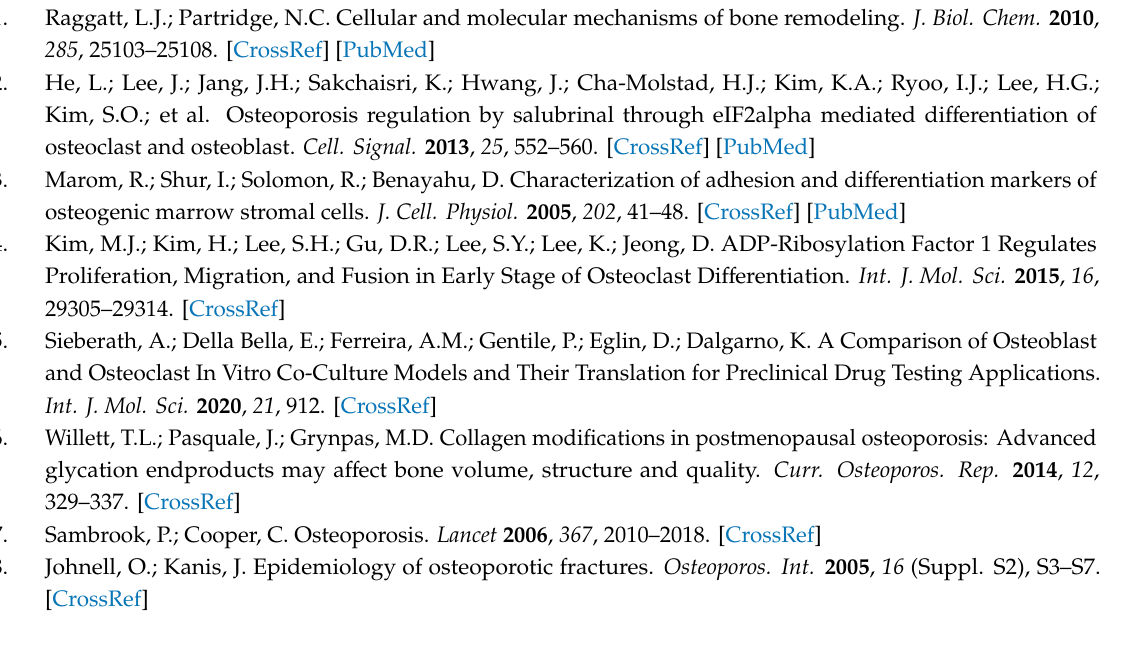
Figure S1: Fractionation and isolation of the bioactive component isolated from LRC, Figure S2: 1 H-NMR (a), 13 C-NMR (b), and mass (c) spectrum of scopolin; Figure S3: Scopolin increased alkaline phosphatase (ALP) activity after 3 and 5 days of incubation. The cells were cultured with three di ff erent concentrations of scopolin (1, 5, and 10 µ M), and alkaline phosphatase (ALP) activity was measured. * p < 0.05 vs. control, Figure S4: Scopolin did not a ff ect the proliferation of osteoblastic cells. The cells were cultured with three di ff erent concentrations of scopolin (1, 5, and 10 µ M) for 5 days, and cell viability was measured. Figure S5: Scopolin reduced osteoclastic di ff erentiation in monocytes isolated from the bone marrow. The monocyte cells were cultured for 3 and 5 days in the presence of 30 ng / mL M-CSF and 50 ng / mL RANKL (induction) or in the presence of M-CSF and RANKL with 1, 5, or 10 µ M of scopolin. * p < 0.05 vs. control, Figure S6: Co-culture of isolated monocytes with MC3T3-E1 osteoblastic cell line cells increased osteoblast di ff erentiation compared to a single-culture of MC3T3-E1 cells. The isolated monocytes and MC3T3-E1 cells were co-cultured for 48 h and ALP activity was measured to determine osteoblast di ff erentiation. * p < 0.05. vs.